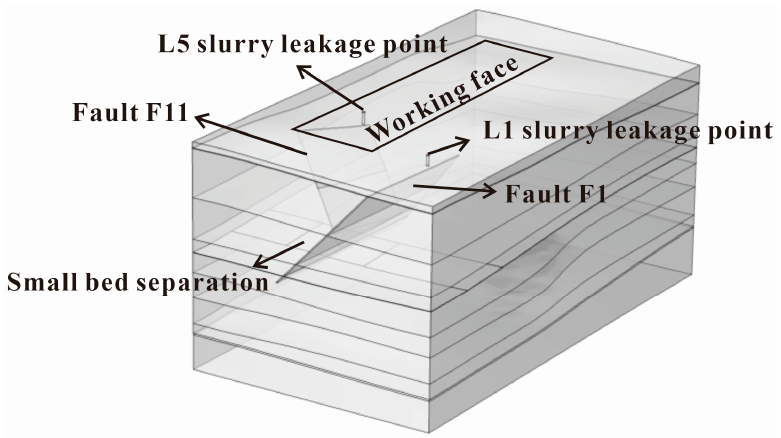
between layers 4 and 5 of the model. The small bed separation was set in the middle of the working face width direction, with the projection of the starting boundary on the surface on the surface coinciding with the starting boundary of the working face. The length and coinciding with the starting boundary of the working face. The length and width of the width of the small bed separation are both 140 m, and the grouting hole is located in the small bed separation are both 140 m, and the grouting hole is located in the centre of the centre of the bed separation. Details of the numerical model are shown in Figure 8. bed separation. Details of the numerical model are shown in Figure 8.